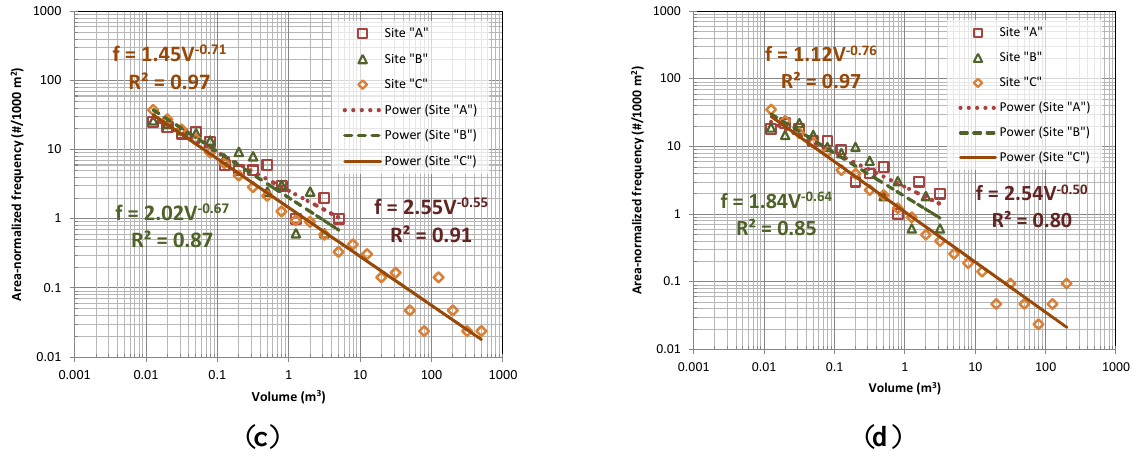
Figure 22. Comparison of magnitude-frequency relationships (2013 to 2014, 0.05 cm holes filled models) and power law regressions for each site, normalized to an equivalent 1000 m 2 area based on events >0.001 m 3 ( a ) with and ( b ) without hole filling and events >0.01 m 3 ( c ) with and ( d ) without hole